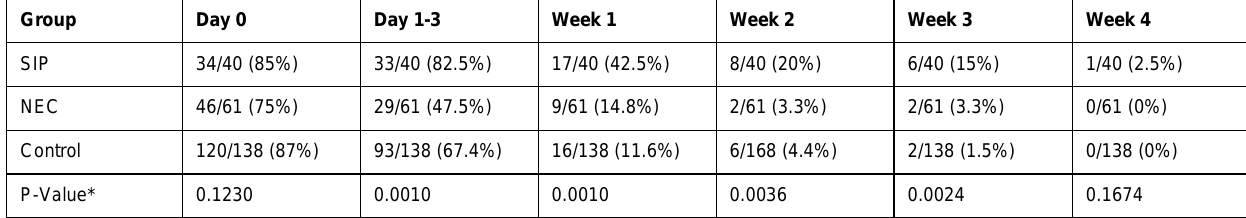
Table 5. The proportion of individuals with NRBC greater than